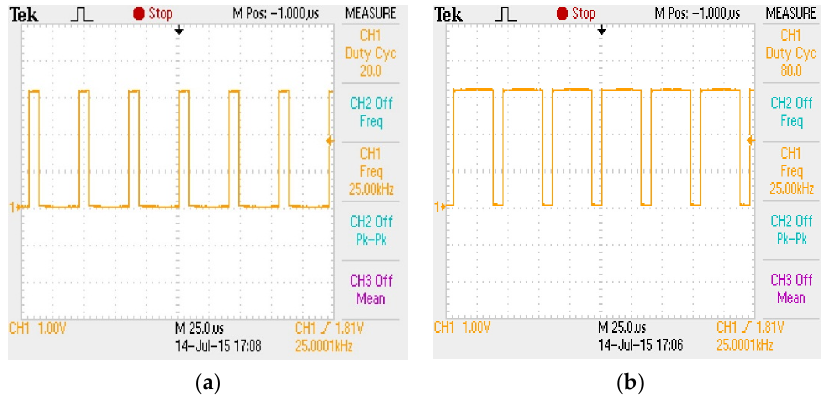
Figure 10. The duty cycle for a reference signal value of 0.2 by defining the third and fourth event managers as ( a ) ”clear” and “set” and ( b ) “set” and “clear”.